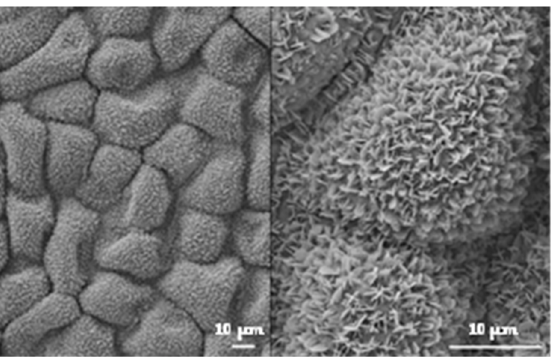
Figure 1. SEM images of a Euphorbia leaf. Credits: Maxime Bronchy—EDF R&D MMC 2017.